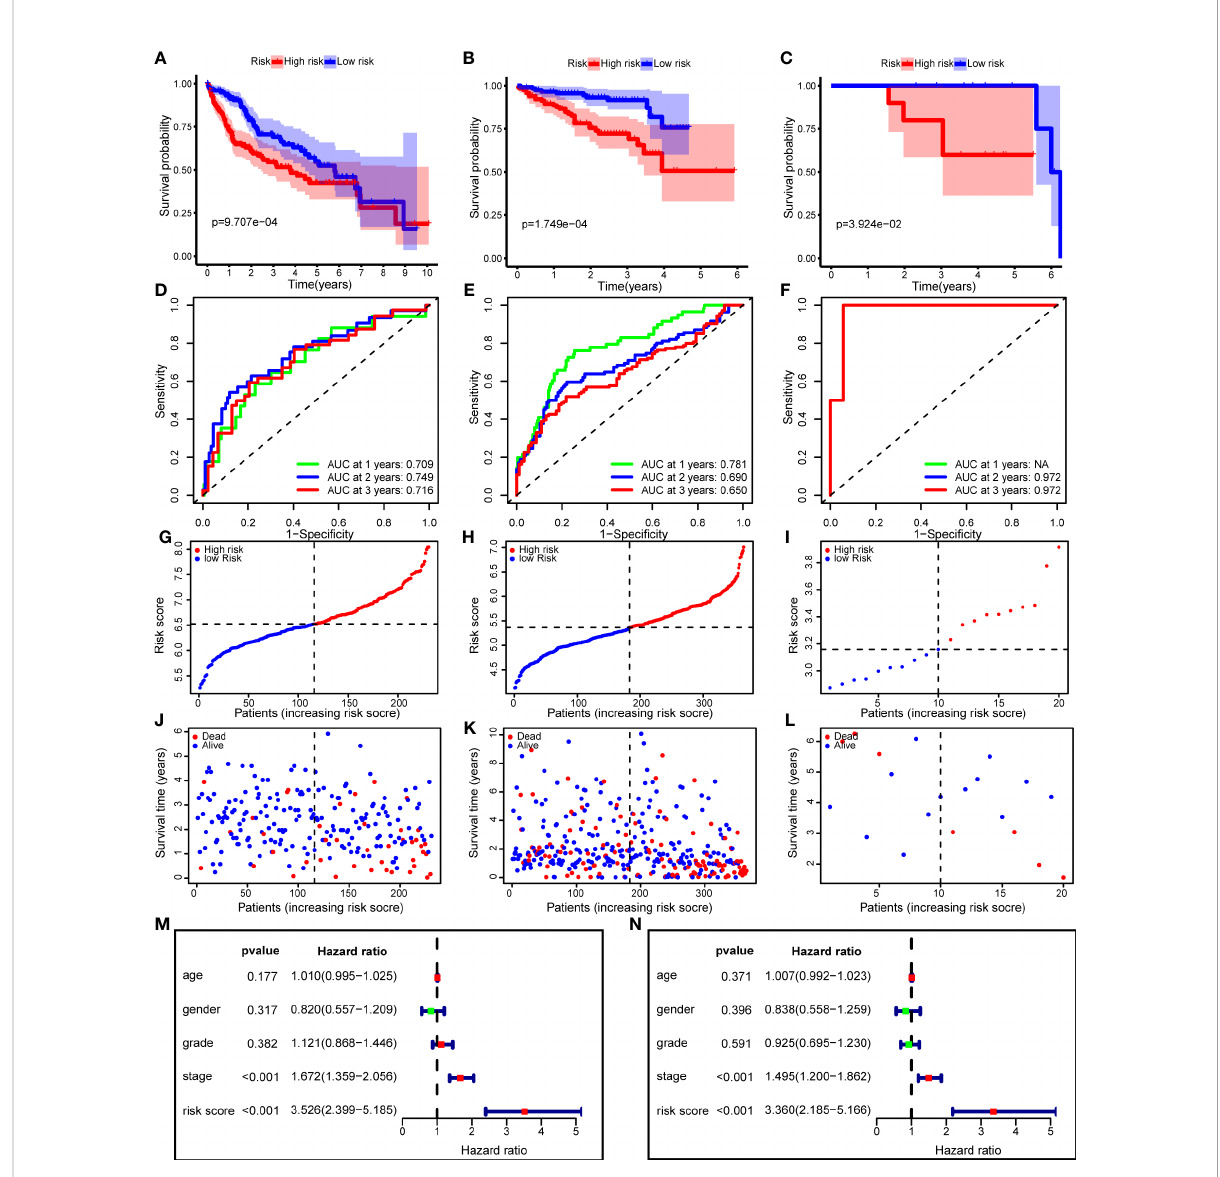
FIGURE 8 The risk model performance in training cohort and two validation cohorts. (A – C) Kaplan-Meier curves for the OS of patients in the high- and low-risk group in the TCGA cohort (A) , ICGC cohort (B) and PUMCH cohort (C) . (D – F) AUC of time-dependent ROC curves in the TCGA cohort (D) , ICGC cohort (E) and PUMCH cohort (F) . (G – I) The distribution and median value of the risk scores in the TCGA cohort (G) , ICGC cohort (H) and PUMCH cohort (I) . (J – L) The distributions of risk scores, survival states and survival outcomes in the TCGA cohort (J) , ICGC cohort (K) and PUMCH cohort (L) . (M, N) Forest plots showing the univariate (M) and multivariate (N) Cox regression analyses regarding OS in the TCGA cohort. OS, Overall survival, AUC, area under the curve, ROC, receiver operating characteristic, TCGA, The Cancer Genome Atlas,